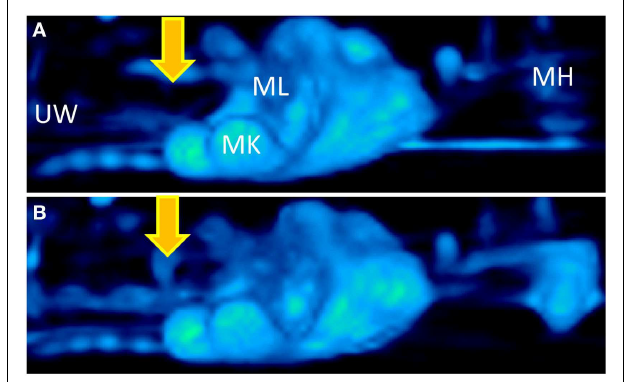
FIGURE 2 |Three dimensional projections of PET images of 11 C-verapamil radioactivity in pregnant Macaca nemestrina before (A) and during (B) administration of cyclosporineA (CsA; 12mg/kg/h). Fetal liver was the reporter of 11 C-radioactivity that crossed the placental barrier. Because of P-gp inhibition, CsA significantly increased the distribution of 11 C-radioactivity into fetal liver.Thus, the fetal liver is seen in the figure only in B (indicated by yellow arrows). MH, maternal head; MK, maternal kidneys; ML, maternal liver; UW, uterine wall. Based on studies conducted by Eyal et al.